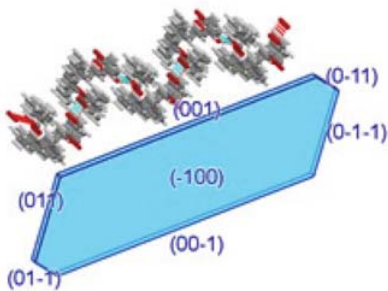
Figure 6 : A zig-zag pattern of simvastatin molecules bound toget- her with hydrogen bonds (blue)